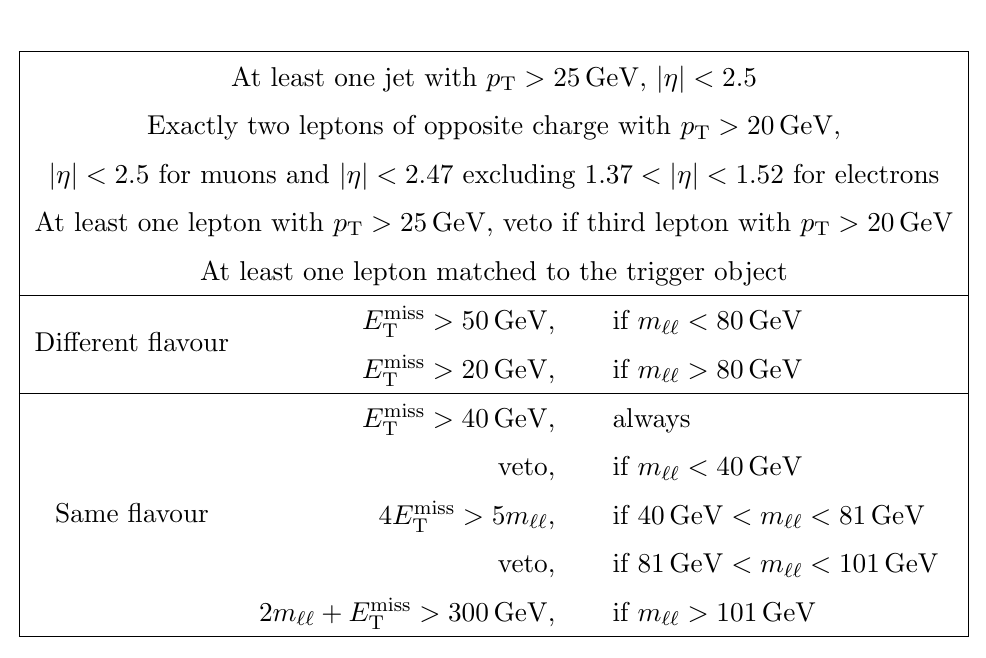
Table 1. Summary of event selection criteria used in the